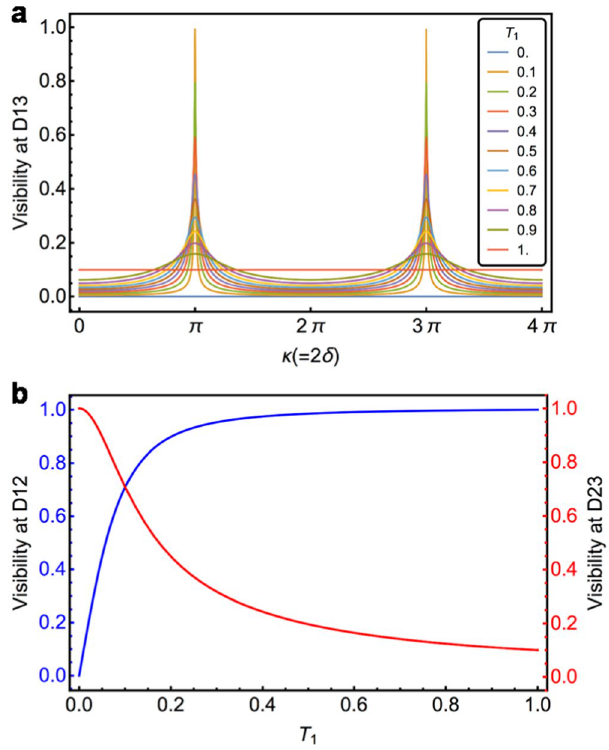
Figure 2. Numerical calculation results. ( a ) Visibility of interference fringe at D13, V 13 , with respect to amplitude phase gained by a round trip in cavity, κ = 2 δ , for varying transmissivity ( T 1 ) of OS1 with T 2 = 0.1. We note that transmission becomes 1 on resonance for T 2 = T 1 due to the cavity input-output relation. ( b ) Visibility of interference fringe at D12 (blue) and D23 (red), V 23 and V 12 , with respect to amplitude transmissivity of OS1, when T 2 =